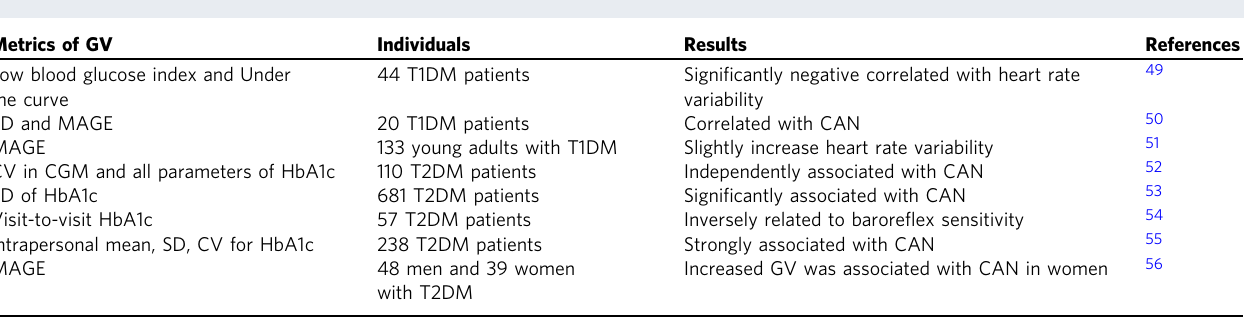
Fig. 1 Possible mechanism of GV causing DN. The pathogenesis of DN is complex, and the possible mechanisms can be divided into oxidative stress, in fl ammatory reactions, etc. The possible mechanisms of GV causing CAN, DPN, and cognitive impairment are as follows: a GV increased ROS, which activated the NRLP3 in fl ammasome and inhibited autonomic ganglion synaptic transmission, thereby leading to CAN; b GV induces oxidative stress and in fl ammatory response by activating the NF-kB pathway or PKC, thereby causing DPN; c GV causes cognitive impairment by inhibiting Akt/GSK3 β pathway to hyperphosphorylate Tau protein. GV glycemic variability, ROS reactive oxygen species, CAN cardiovascular autonomic neuropathy, DPN diabetic peripheral neuropathy. Table 1 Roles of GV in